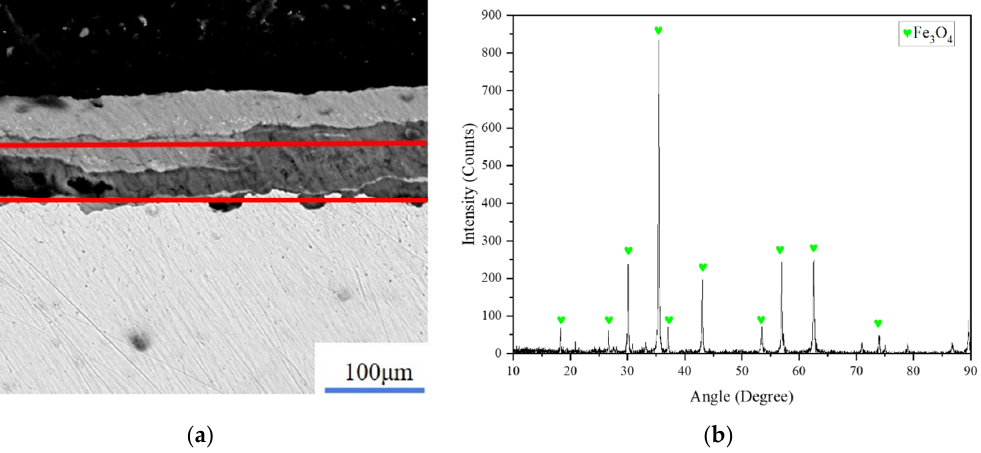
Figure 2. The layered structure distribution of Fe 3 O 4 and X ‐ ray ‐ diffraction analysis. ( a ) Distribution of Fe 3 O 4 ; ( b ) X ‐ ray ‐ diffraction analysis of Fe 3 O 4.